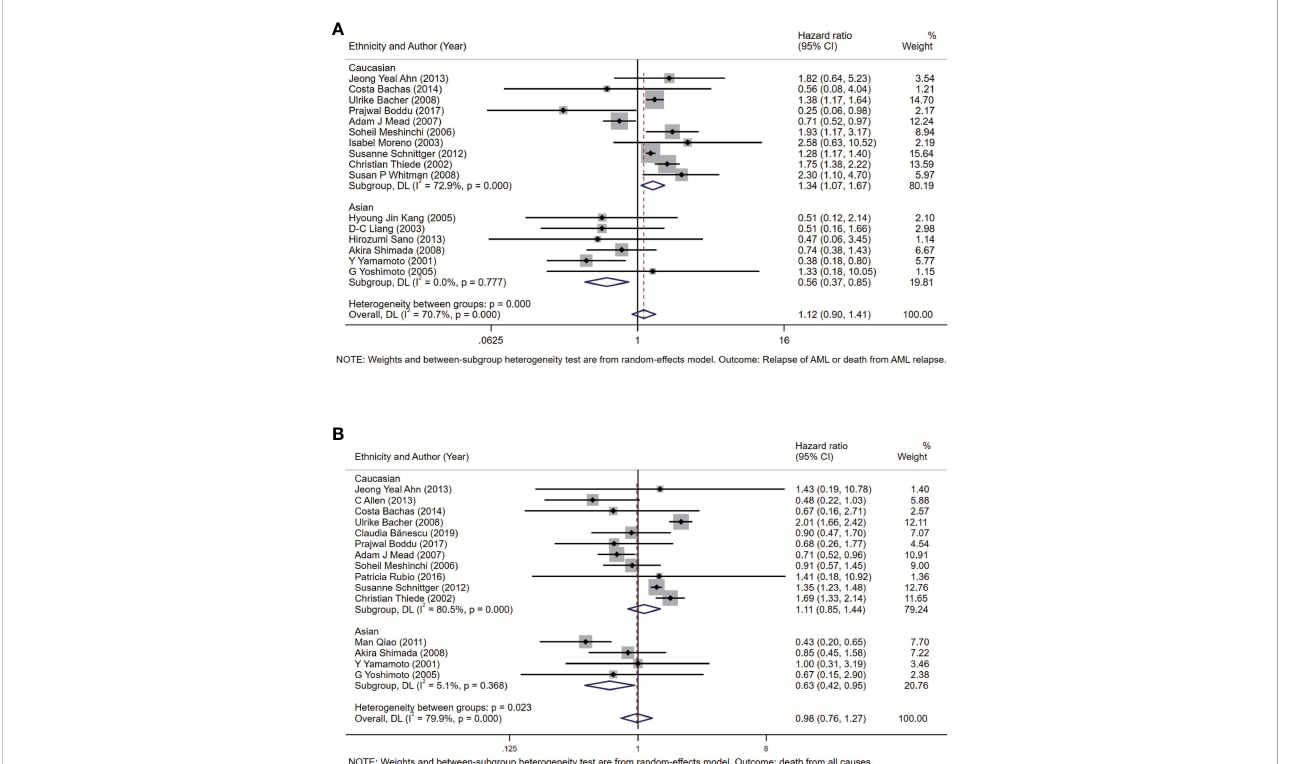
FIGURE 4 Forest plots of HRs and 95% CI for DFS (A) and OS (B) in patients with AML in the Asian subgroup and the Caucasian subgroup. The size of blocks or diamonds represents the weight in this meta-analysis, and the length of straight line segment represents the width of 95% CI. HR, hazard ratio; CI, con fi dence intervals; DFS, disease-free survival; OS, overall survival; AML, acute myeloid